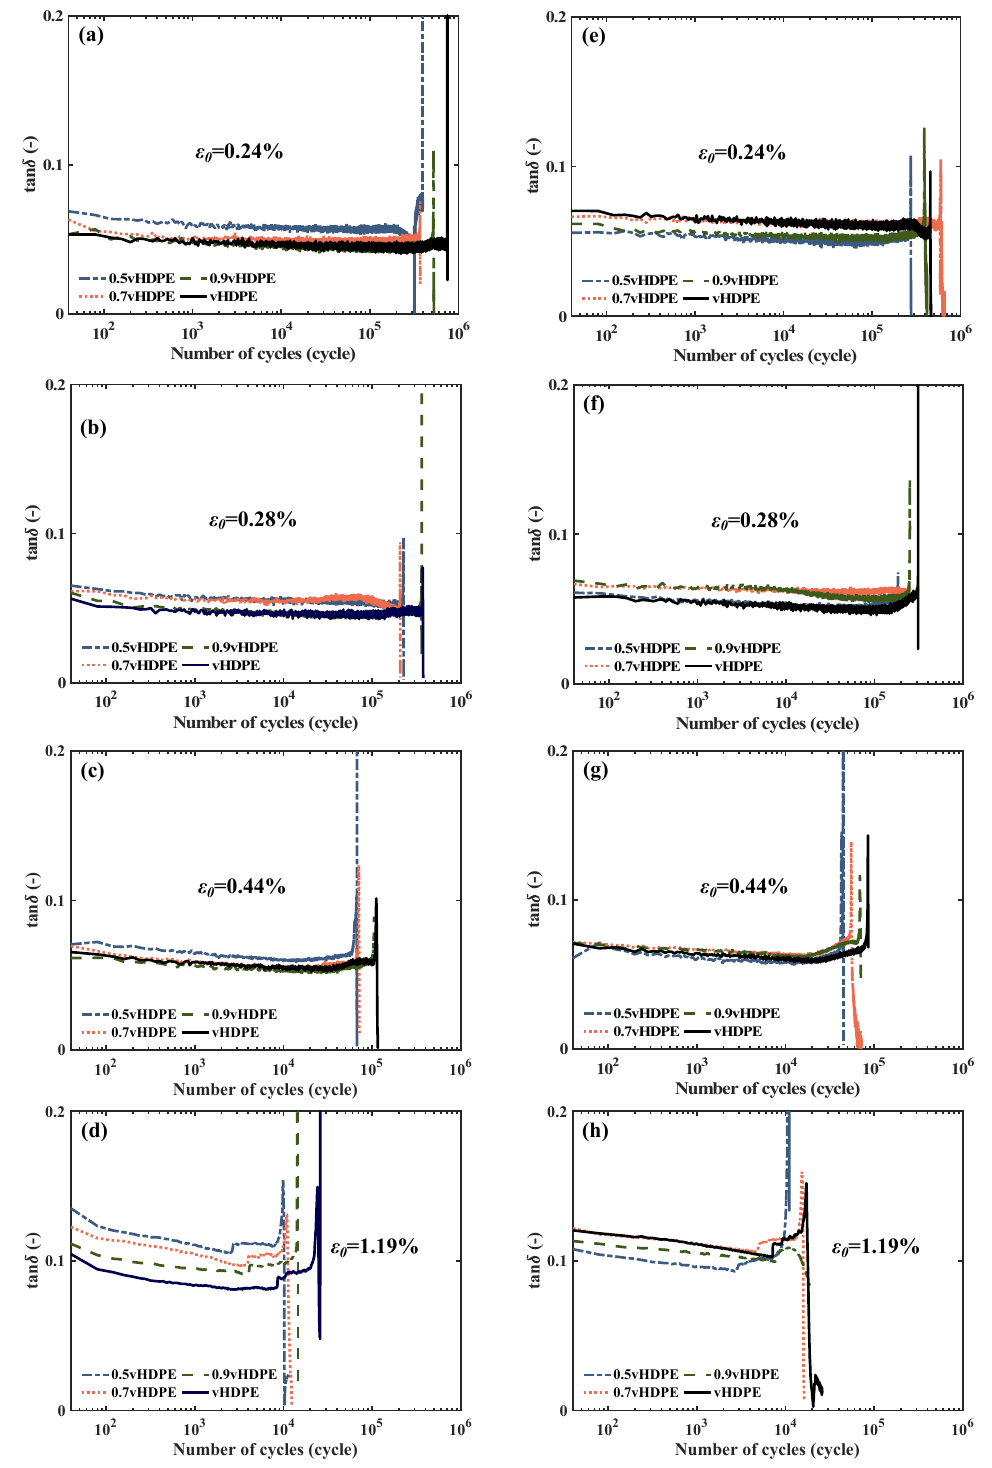
Figure 10. Effect of the vHDPE content on the fatigue behavior under different strain amplitudes for the blends processed by both mixing methods: ( a – d ) PM and ( e – h ) EM.